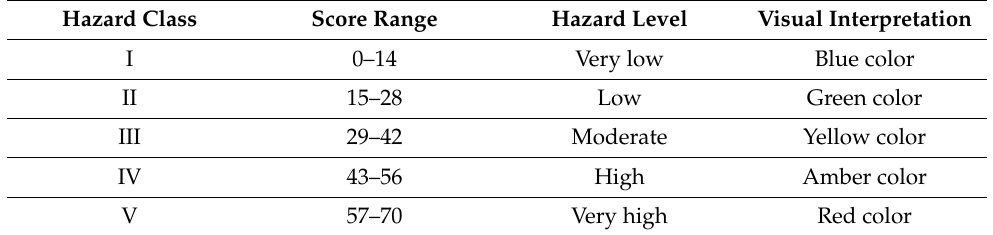
Table 8. Rockfall hazard level classification based on the proposed rating system.